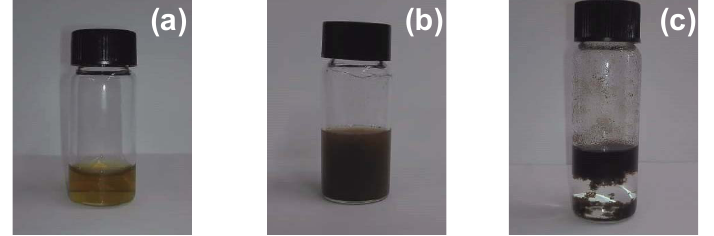
Figure 2. Photographs: ( a ) GO dispersion; ( b ) Fe Fe O /GS solution. 3 4